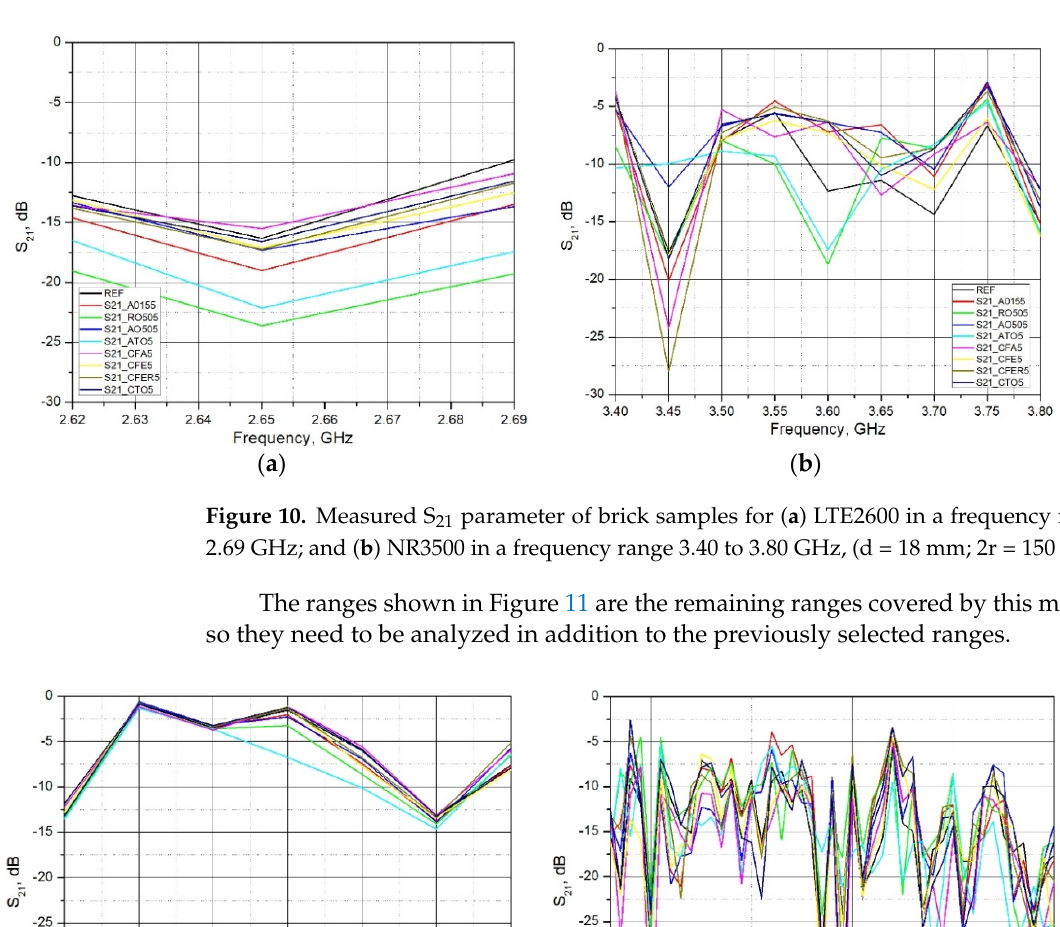
Figure 9. Measured S 21 parameter of brick samples for ( a ) LTE1800 in a frequency range 1.8 to 1.88 GHz; and ( b ) LTE2100 in a frequency range 2.11 to 2.17 GHz, (d = 18 mm; 2r = 150 mm).